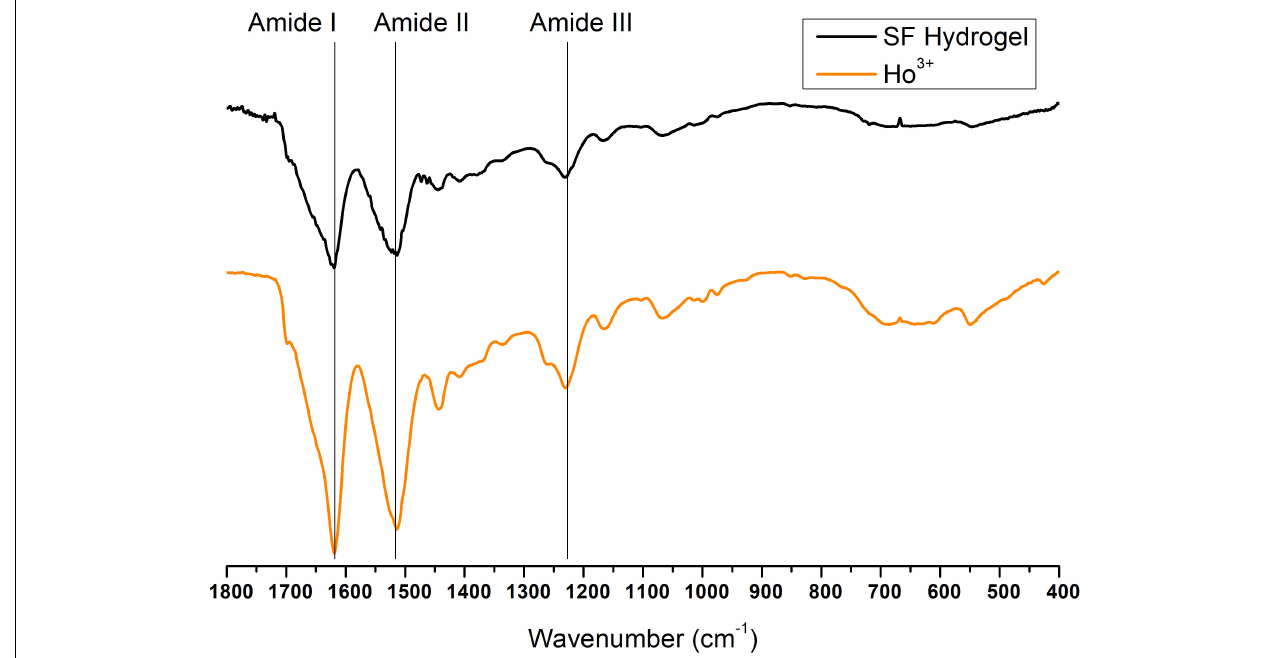
FIGURE 12 | Expansion of the amide band region, between 1,800 and 400 cm − 1 , of the ATR-FTIR spectra of regenerated Ho + 3 -SF